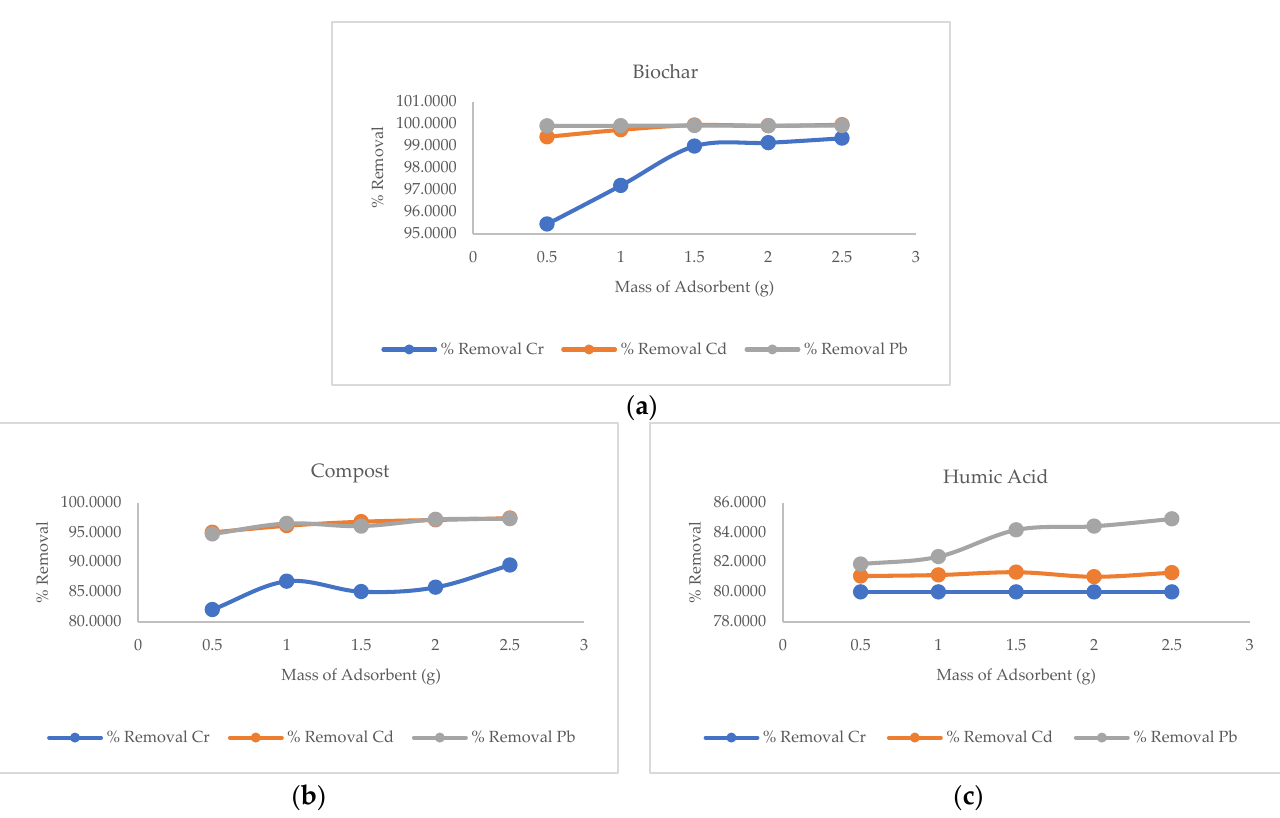
Figure 7. Percent removal of biochar ( a ), compost ( b ) and humic acid ( c ).